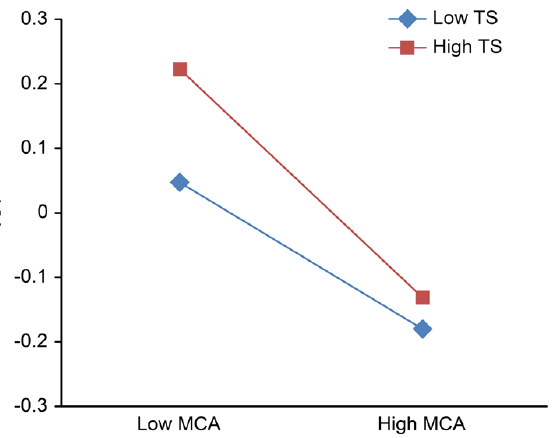
Figure 2. Teacher support adjustment chart a. MCA, mother-adolescent attachment; TS, teacher support; AA, adolescent